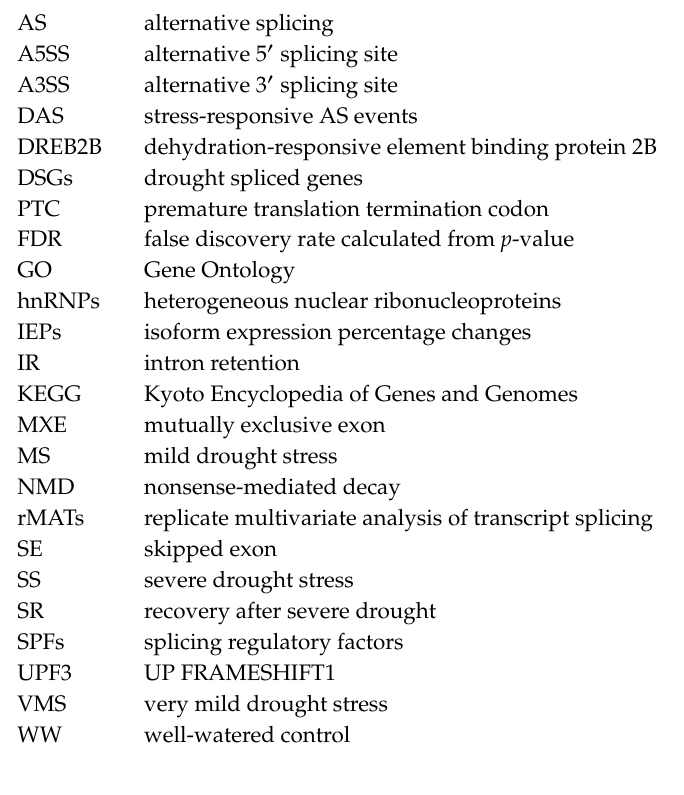
Figure S1: Quality and feature of the RNA-seq datasets used in this study. (A) Chromosome-wise read count distribution of all filtered reads in root samples. Reads were obtained throughout the soybean genome and distributed on di ff erent chromosomes using Williams 82 sequence as a reference. Raw reads were filtered using the criteria of MAPQ > 20 and insert size 100–1000 bp. (B) Normalized gene-body coverage of RNA-seq libraries generated from soybean root. For each library, the average coverage is shown at each relative position along the transcripts’ length. Figure S2: The number of di ff erent AS events in genes expressed in seedlings based on RNA-seq data compared with the annotated gene models under all drought conditions. Blue, exclusion; red, inclusion. Figure S3: Venn diagrams of the di ff erentially spliced AS events derived from five AS types under various drought conditions: (A) SE type, (B) A3 (cid:48) SS type, (C) A5 (cid:48) SS type, (D) RI type, and (E) MXE type. Figure S4: AS profiles of significantly stress-responsive genes under various drought conditions. The bar charts show relative expression levels of alternatively spliced isoform that was well-watered (ww) (blue) and isoform stress (yellow) of AS genes under various drought conditions revealed by RNA-seq. The numbers in each bar indicate the expression percentages of di ff erent isoforms. Figure S5: The top 20 GO enrichment terms (biological process) of DEGs under all conditions. Notes: the blue bar chart represents the gene percent (%) of the GO terms. Figure S6: Clustering analysis of di ff erentially expressed SPF-related genes under various drought treatments. The transcripts per million (TPM) values of expression levels of those genes were used. Upregulated (red) and downregulated (blue) SPF-related genes are presented by di ff erent color scales in the heatmap. Table S1: Raw data and clean data statistics of RNA sequencing. Table S2: The ID list of DSGs. Table S3: DSGs encoding novel transcripts under various drought